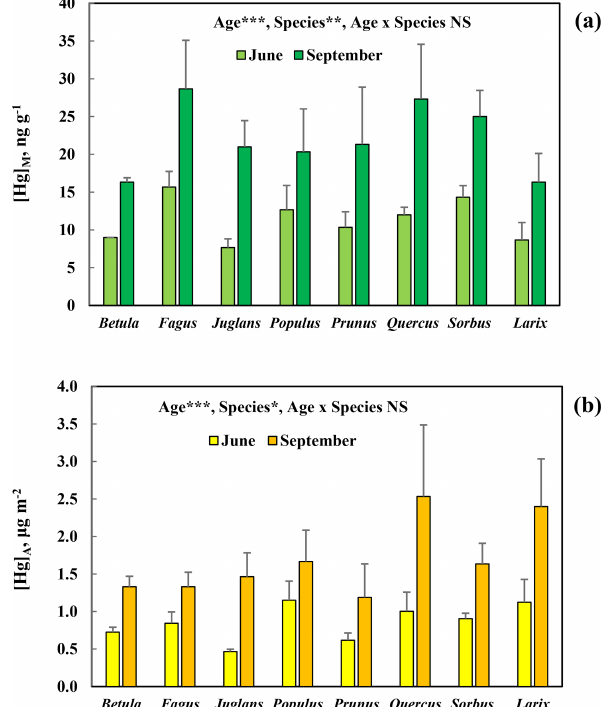
Figure 6. Mass-based [Hg] M (a) and area-based [Hg] A (b) concen- trations of mercury in leaves sampled in June and September from Quercus palustris trees at seven sites with different local air pollu- tion in the city of Gothenburg. Error bars show the standard devi- ation, between the three trees sampled per species; ∗∗∗ p < 0 . 001; NS, non-significant. Site locations and characteristics are available in the supporting